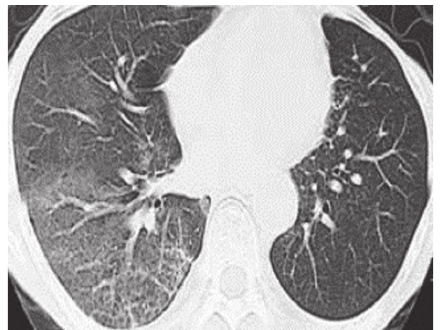
Figure 2: A section of HRCT done prior to discharge showing dramatic improvement in the lung filed